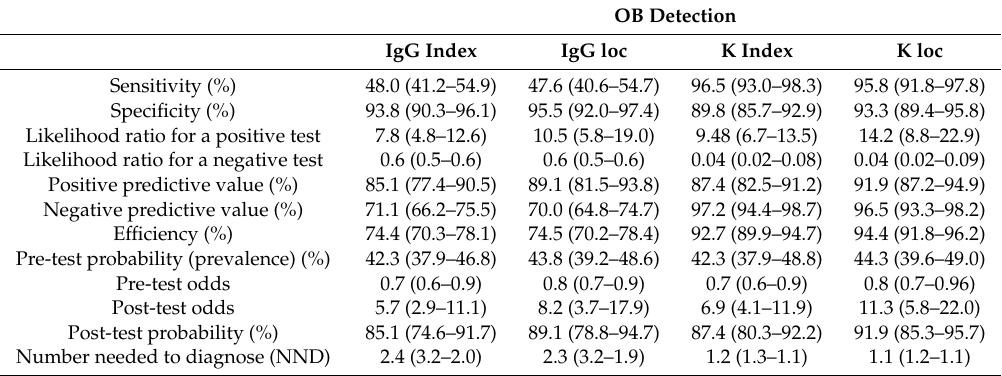
Table 2. Diagnostic performances of IgG index, IgG loc, K index and K loc for OB detection by IEF.